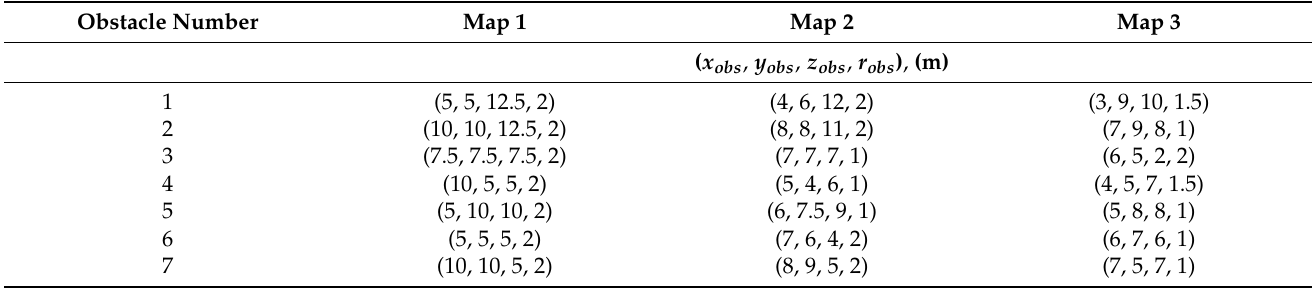
Table 1. Positions of obstacles with 3 different